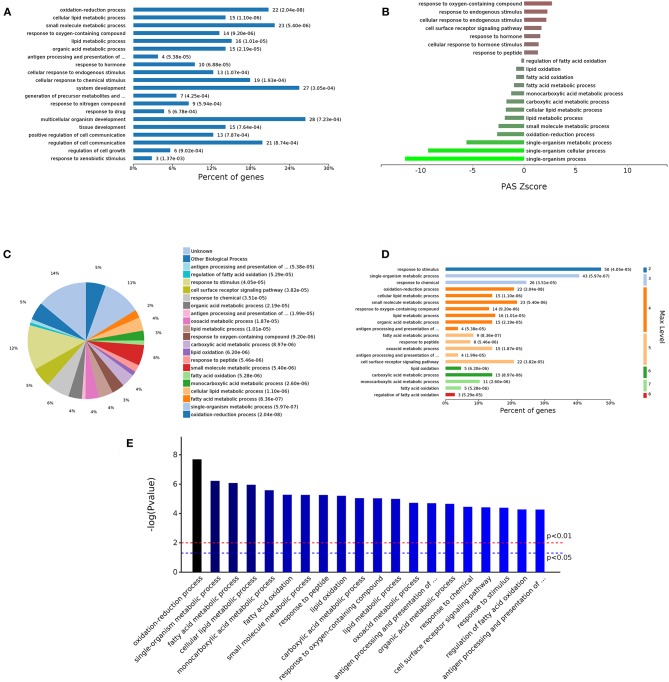
Analysis of 498 different biological process GOs. (A) Percent of genes associated with enriched biological processes. (B) PAS value of enriched biological processes. (C) Expressed proteins associated with enriched biological process. (D) Levels of enriched biological processes. (E) Significantly enriched biological processes.